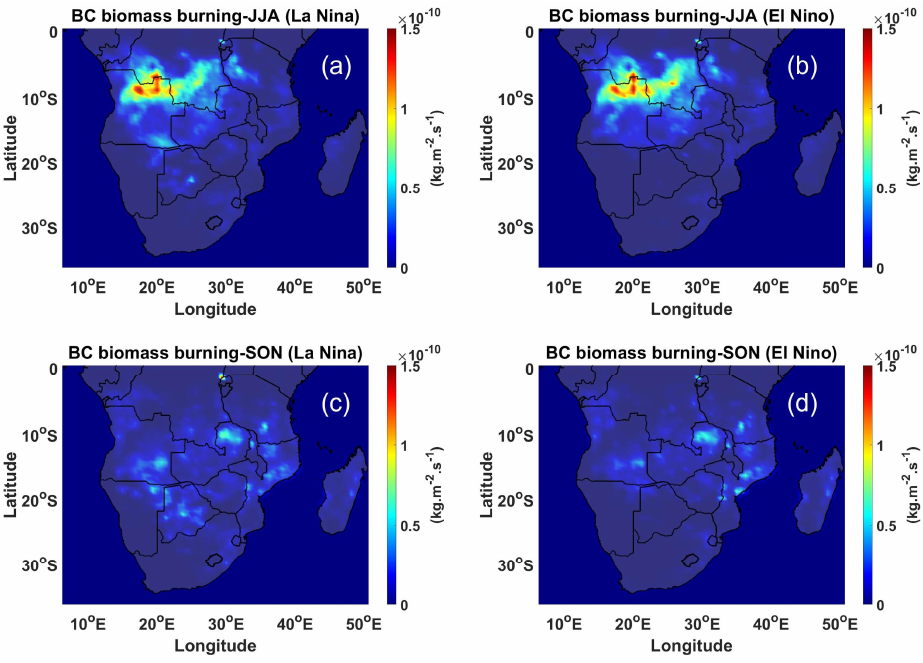
Figure 5. Spatial distribution of BC biomass-burning emissions for the June–July–August (JJA, ( a , b ) and September–October–November (SON, ( c , d )) seasons during the La Niña ( a , c ) and El Niño ( b , d ) events.